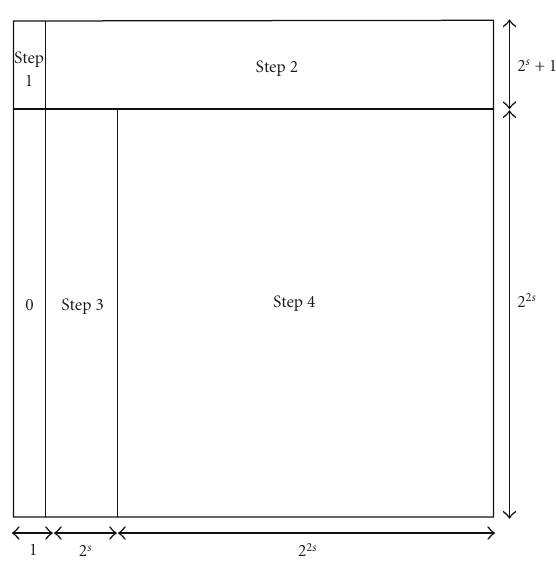
Figure 1: Portion of parity check matrix constructed in each